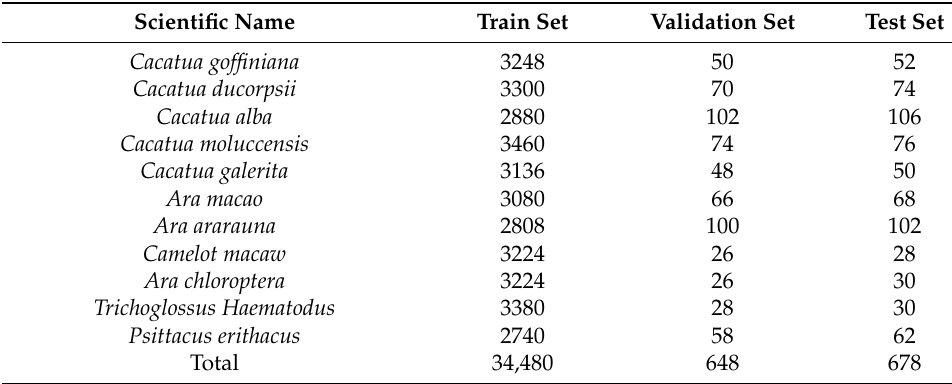
Table 1. Dataset of the 11 parrot species after data augmentation. Figure 2. Data augmentation methods; red box represents the ground-truth. Table 2. Overview of our dataset of the 11 parrot species designated as endangered by CITES.